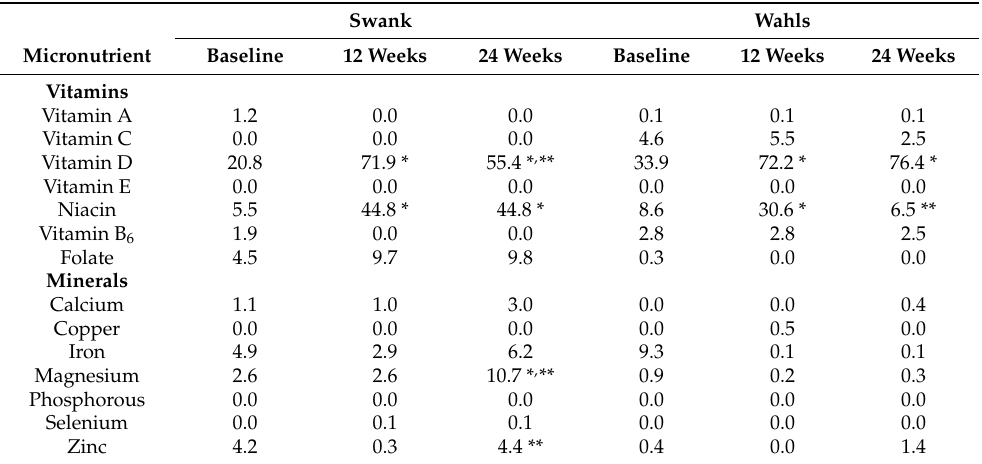
Table 5. Proportion with excessive micronutrient intake from food and supplements at baseline and after adapting the Swank or Wahls diets among individuals with RRMS 1,2 . Swank Wahls